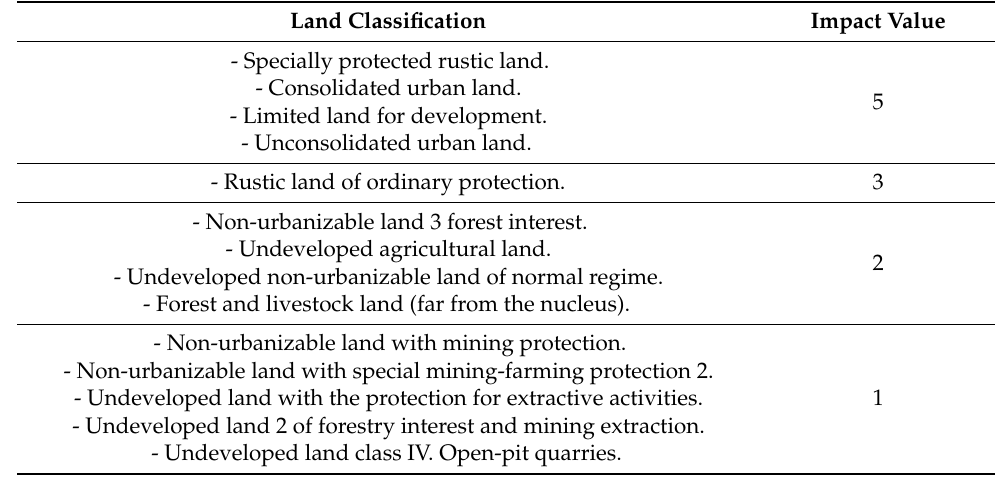
Table 13. Classification of the urban planning component.